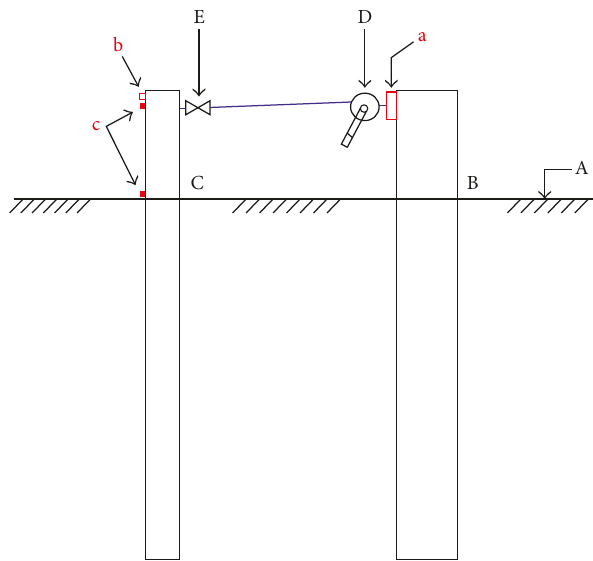
Figure 1: Elevation: test configuration for free-vibration response. The components are (A) soil surface, (B) reaction pile, (C) test pile, (D) chain hoist, (E) quick disconnect, (a) load cell, (b) accelerometer, and (c) displacement measurement. This sketch is not to